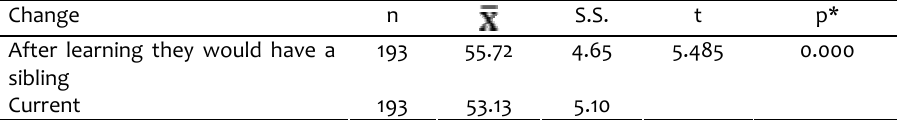
Table 6. Comparison of current jealousy behaviors scores of children and those after learning that they would have a new sibling Change n S.S. t p* 193 55.72 4.65 5.485 193 53.13 5.10